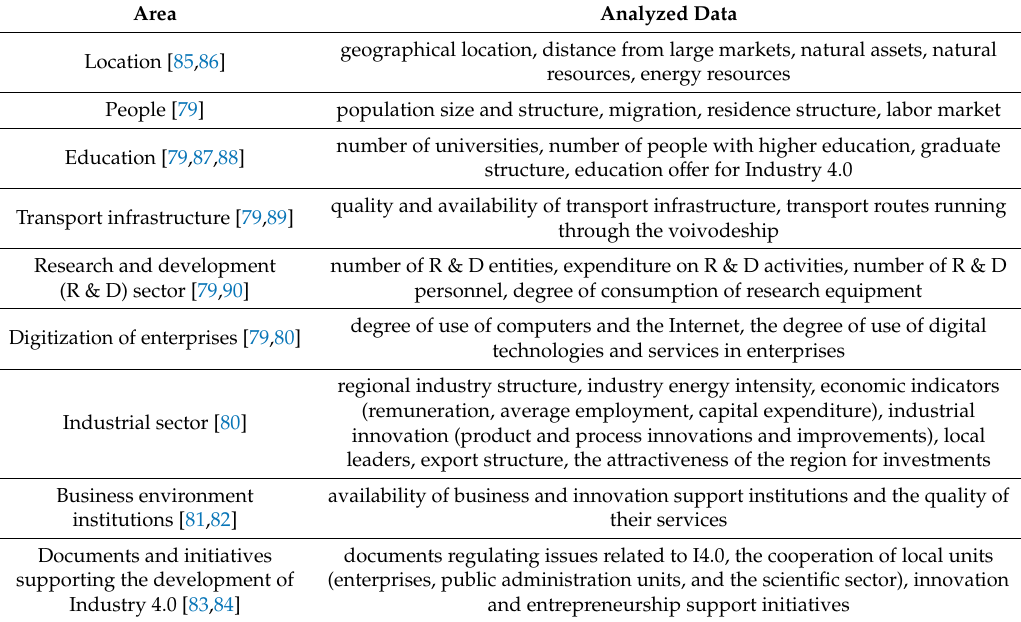
Figure 5. Areas of Industry 4.0 regional environment identified in the study. Table 2. Data analyzed in nine identified areas of the regional environment.